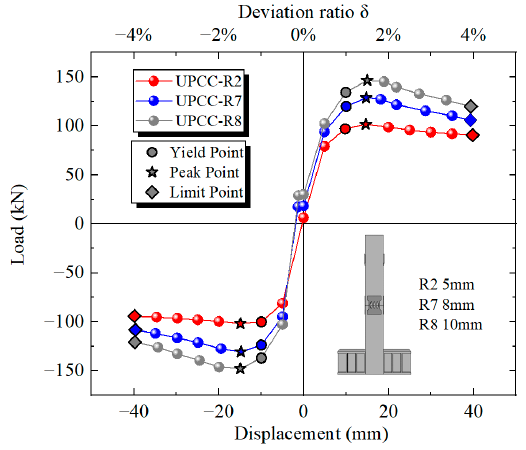
Figure 30. The skeleton curves under different thickness of EREDL. Table 13. The ductility coefficient of specimens under EREDL with different thickness.